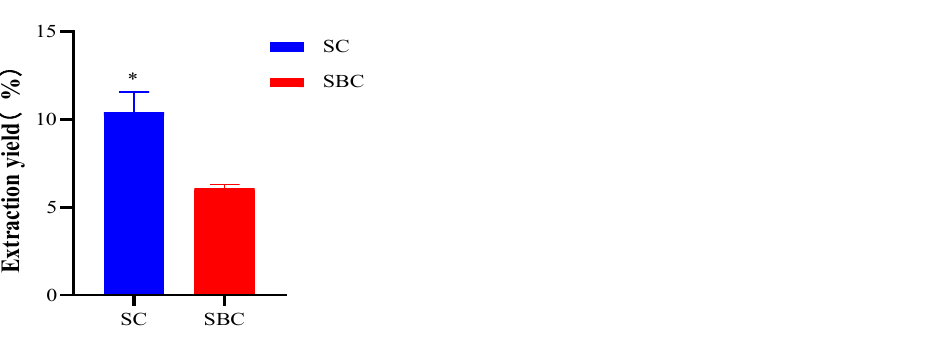
Figure 1. Yields of collagen extracted from C. idella skin (SC) and swim bladder (SBC). * represents significant difference ( p < 0.05)